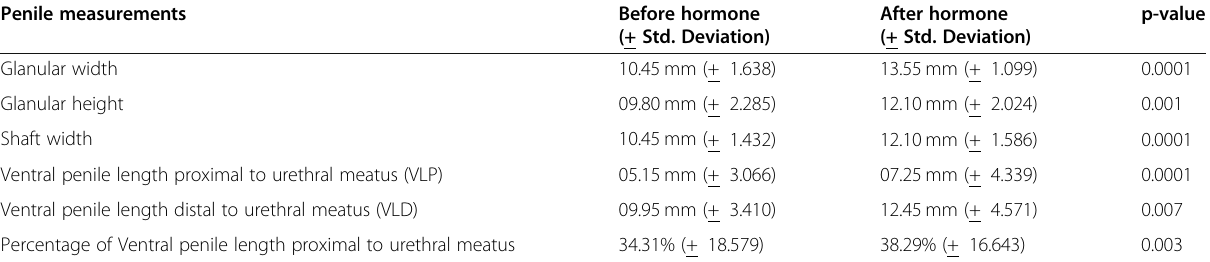
Table 2 Comparison of penile measurements before and after local testosterone application in group A (20 patients; paired t-test) Penile measurements